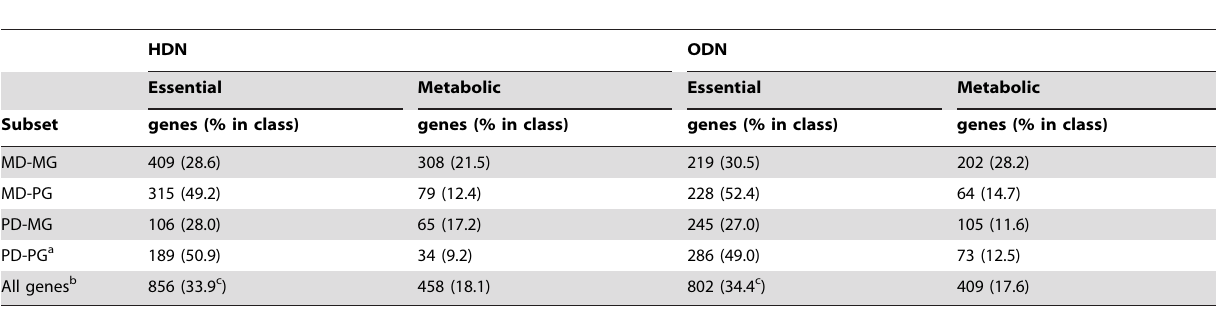
Table 5. Distribution of essential and metabolic genes in current diseases